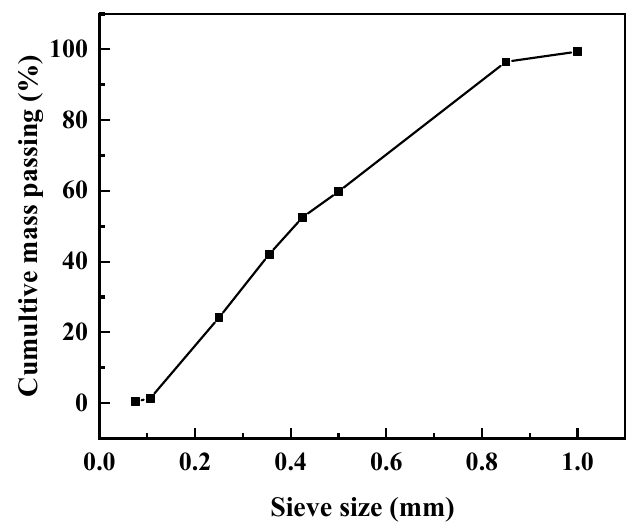
Figure 1. Sand gradation curve.